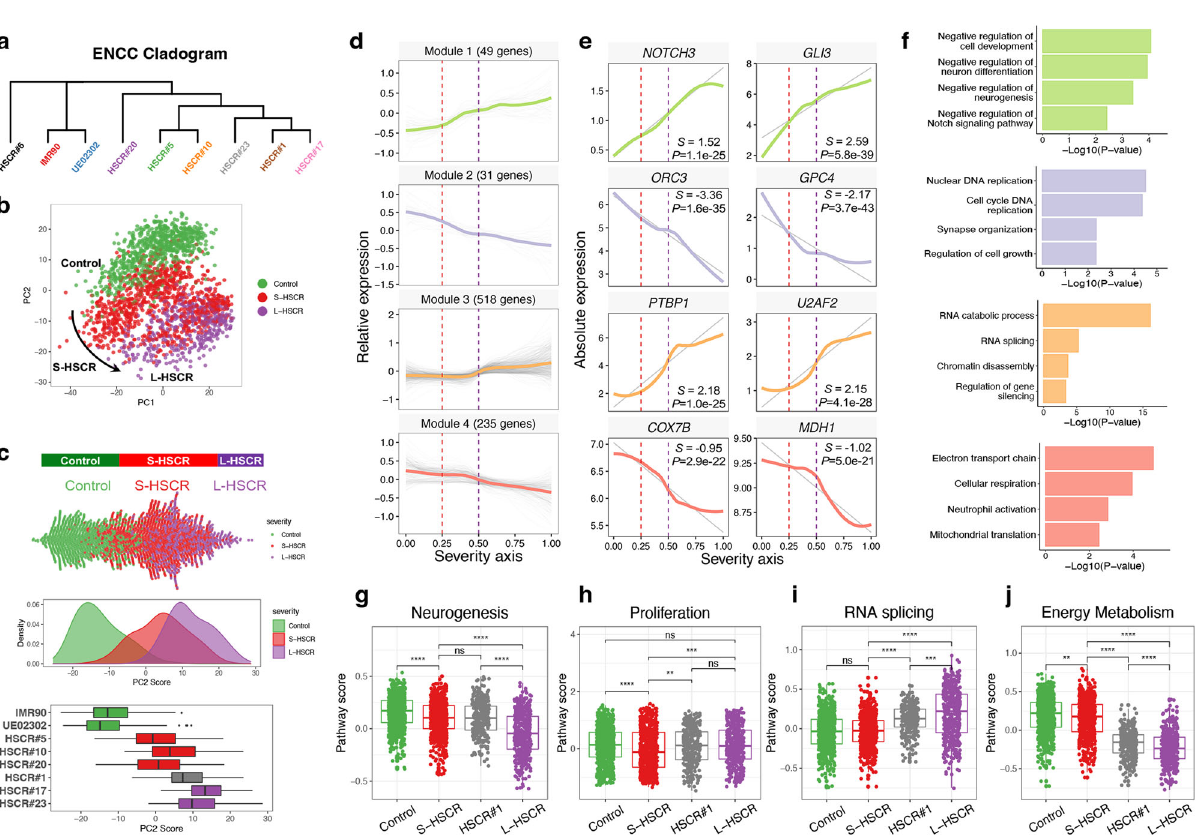
Fig. 2 | Reconstruction of disease severity axis integrating different HSCR states. a Hierarchical clustering by average gene expression. b PCA projection of cells in Cluster 1 based on gene expression pro fi le after excluding the TCA-HSCR- iPSC-line (HSCR#6). c Distribution of cells along PC2 is highly associated with disease severity, as shown in beeswarm, density, and boxplots. Colored by type of HSCR. 379 IMR90 cells, 375 UE02302 cells, 161 HSCR#5 cells, 296 HSCR#10 cells, 186 HSCR#20 cells, 306 HSCR#1 cells, 187 HSCR#17 cells, and 246 HSCR#23 cells were included. d The expression dynamics of 833 top DEGs were cataloged into four major modules, colored by modules. Thick lines indicate the average gene expression patterns of each module. All 2136 cells ordered by severity axis were includedto fi ttheexpressioncurve. e Genesignaturesand expressiondynamicsof representative genes in each gene module. The relative expression levels of these genesareshownasaLOESSsmooth fi tline(coloredline)andthebest- fi tlines(gray